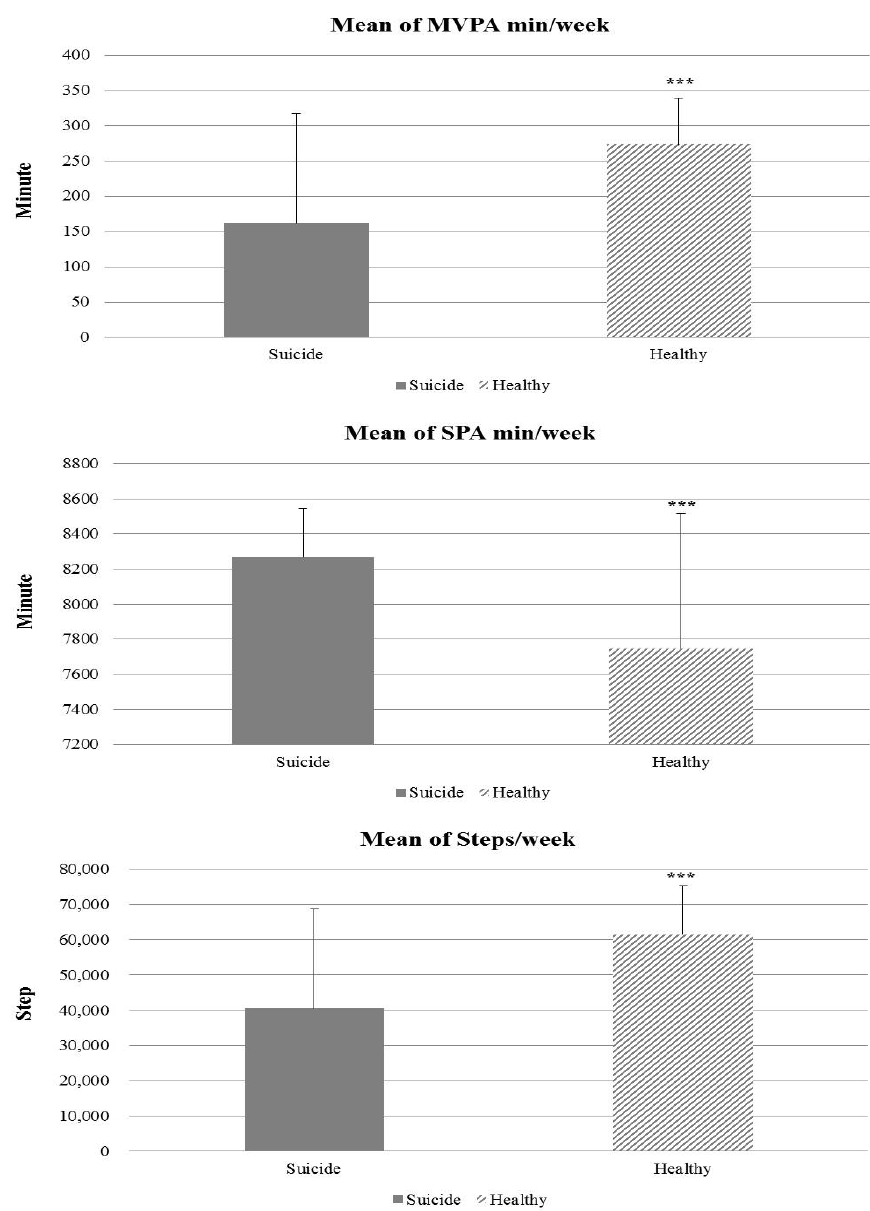
Figure 1. Comparison of average physical activity time and step counts calculated by an accelerometer for a week between the suicide and healthy group. The significant differences between the two groups. *** < 0.001, Error bars represent the 95% confidence interval. MVPA: moderate to vigorous physical activity, SPA: sedentary physical activity.